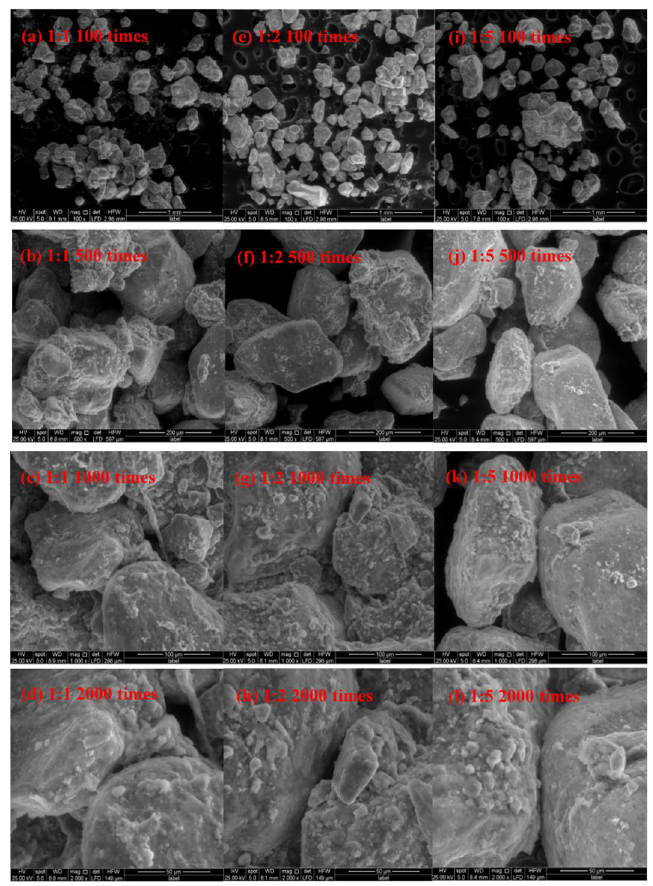
Figure 6. Scanning electron microscopy images of different proportions of compound soil after 3 years of planting. ( a – d ), ( e – h ), ( i – l ) are images of soft rock and sand compound ratios of 1:1, 1:2, 1:5, respectively; ( a , e